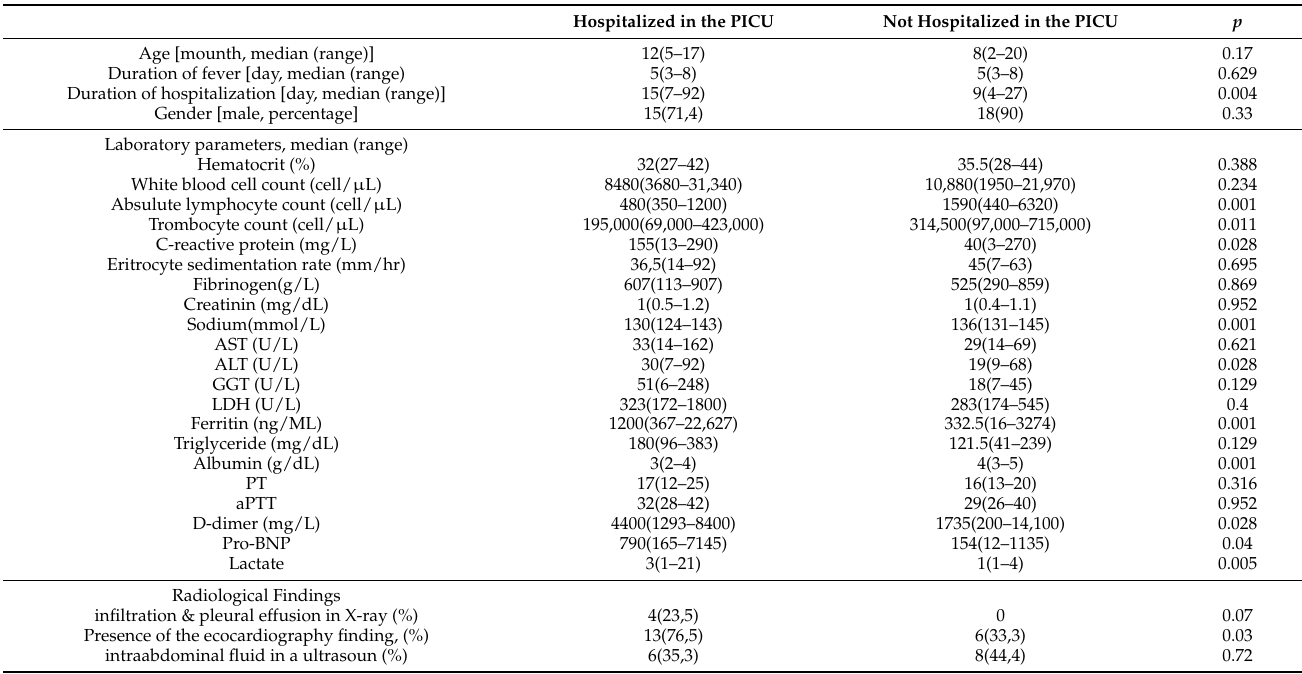
Table 2. Comparison of the clinical, laboratory and radiological findings of the patients with those who were hospitalized in the PICU and non-